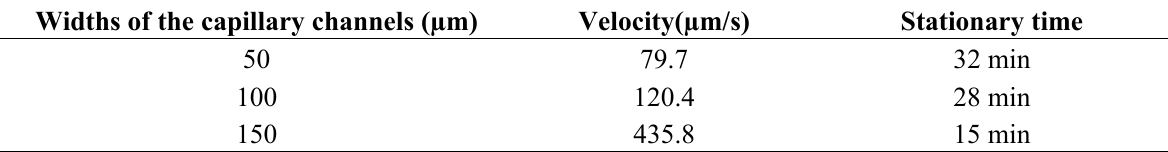
Table 4. The fluid stationary time is for the stop valves with the same 170° expansion angle and the same depth of 100 µm but the valve having three different aspect ratios of the patterns. The PEO-PDMS cover is in the 0.4% PEO concentration.